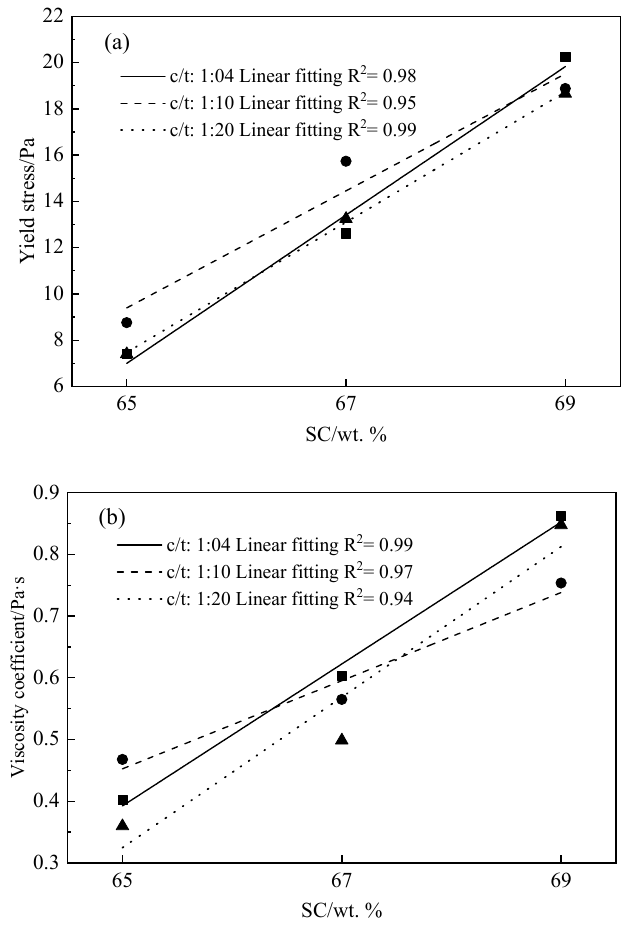
Figure 7. Yield stress ( a ) and viscosity coefficient ( b ) of CTB with different solid content (SC) values. c/t stands for cement ‐ to ‐ tailings ratio. ● : c/t:1:10; ▲ : c/t:1:20; ■ : c/t:1:04.